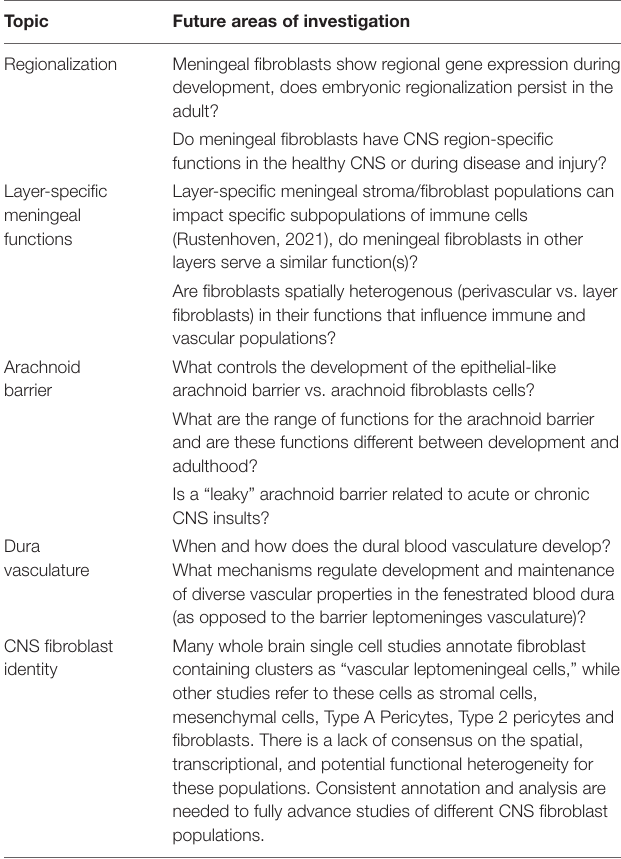
TABLE 1 | Future areas of investigation in meninges biology.